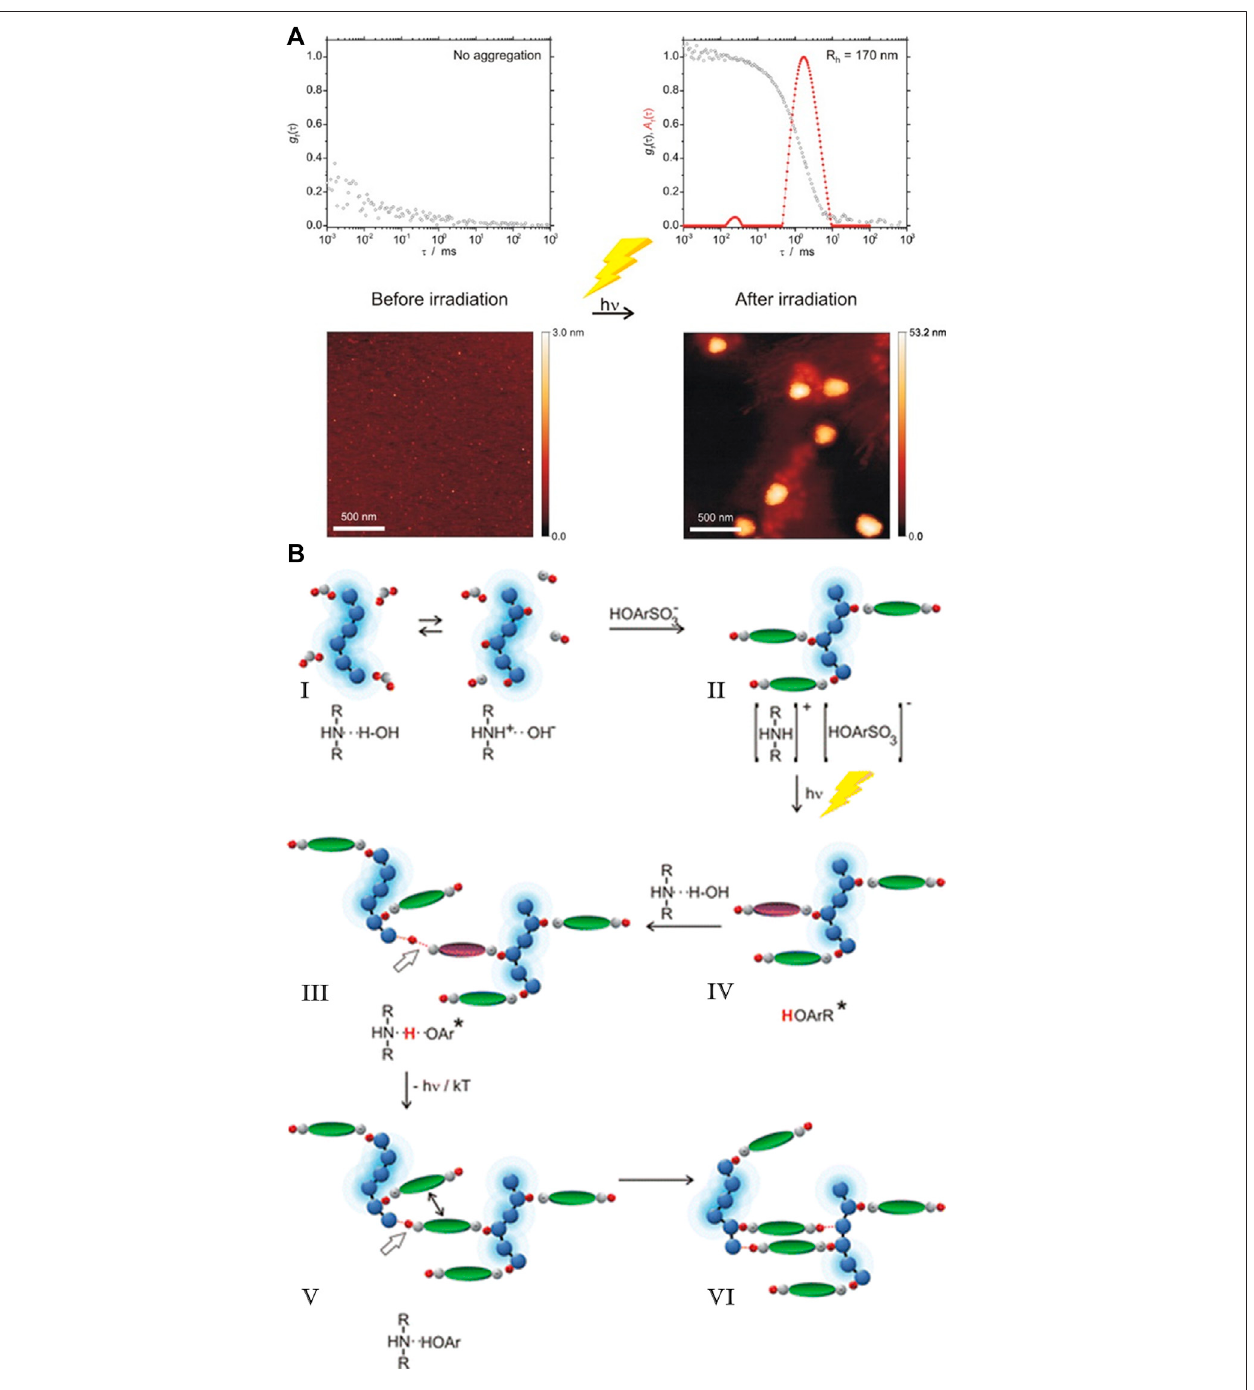
FIGURE24| PhotoacidwhichchangesthepKaintheexcited stateactingasabuildingblockinelectrostatic self-assembly withlinearoligo (ethyleneimine): A DLS and AFM before (left) and after (right) UV irradiation. B : light-induced assembly mechanism (Cardenas-Daw and Gröhn, 2015). Reprinted with permission. Copyright © 2015 American Chemical Society.